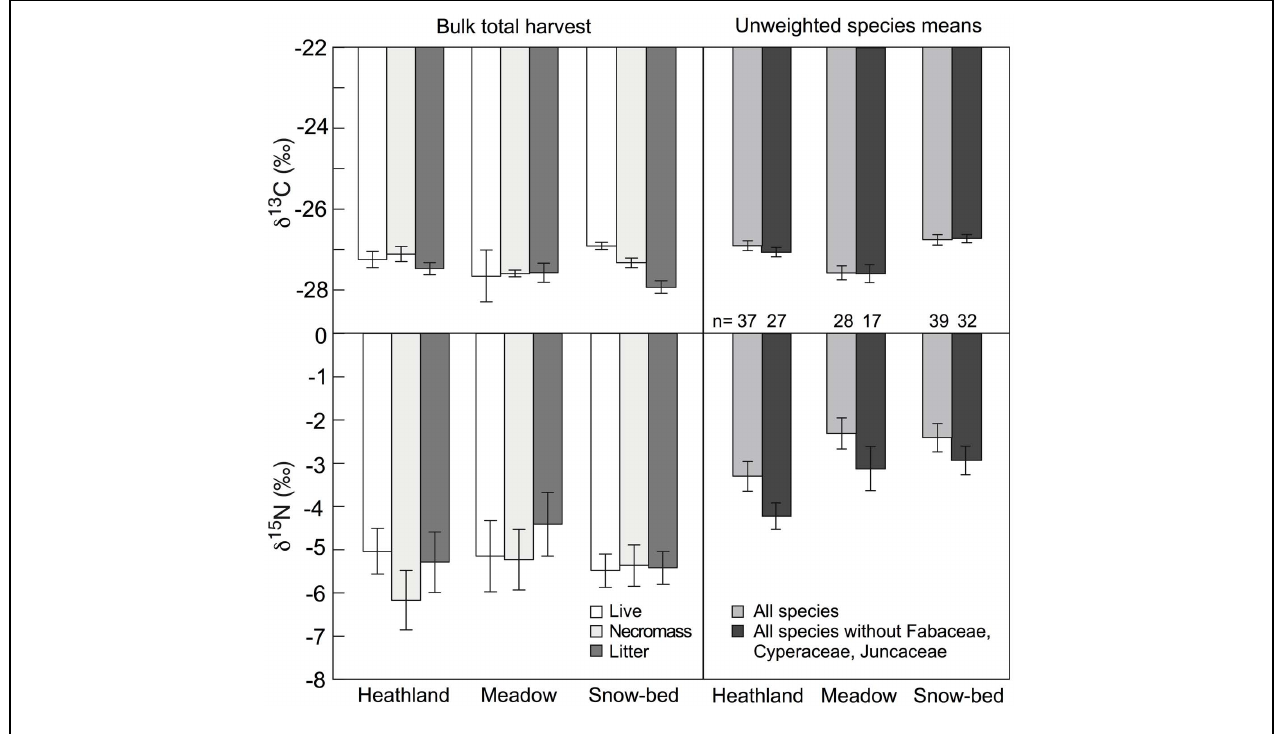
FIGURE 7 | Left: means of δ 13 C and δ 15 N signals in different types of bulk plant dry matter fractions in Nardus heath, Festuca meadow, and snow-bed communities (mean ± SE, n = 4 harvested sub-plots per community type). None of the means of δ 13 C (live: F = 0.9, p = 0.427; necromass: F = 3.1, p = 0.095; litter; F = 1.6, p = 0.246) and δ 15 N (live: